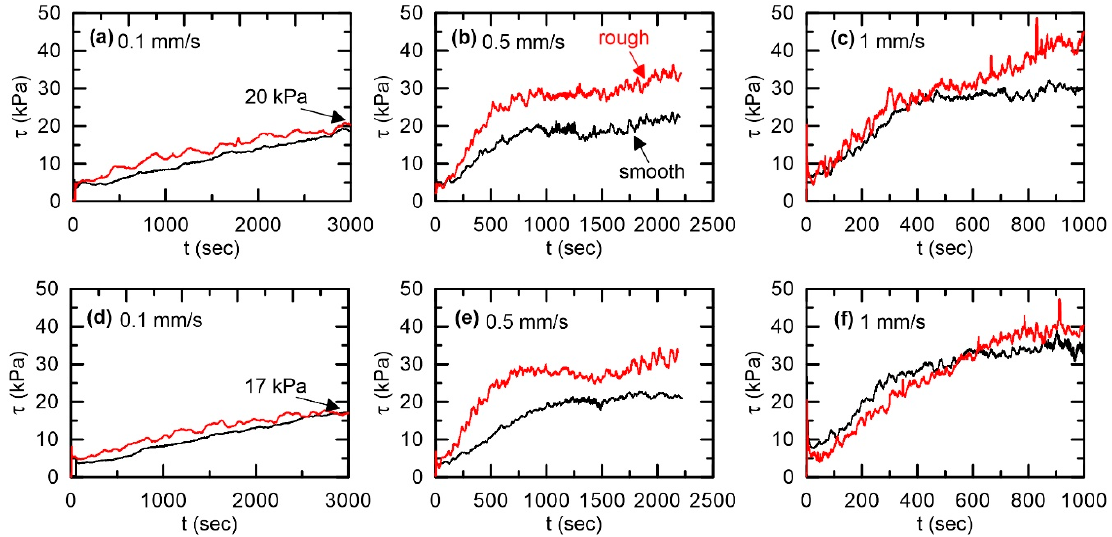
Figure 4. Comparison between smooth and rough surfaces for different shear velocities of 0.1, 0.5, and 1 mm/s: ( a – c ) Drained and ( d – f ) undrained conditions. ( a , d ): 0.1 mm/s; ( b , e ): 0.5 mm/s; and ( c , f ): 1 mm/s.